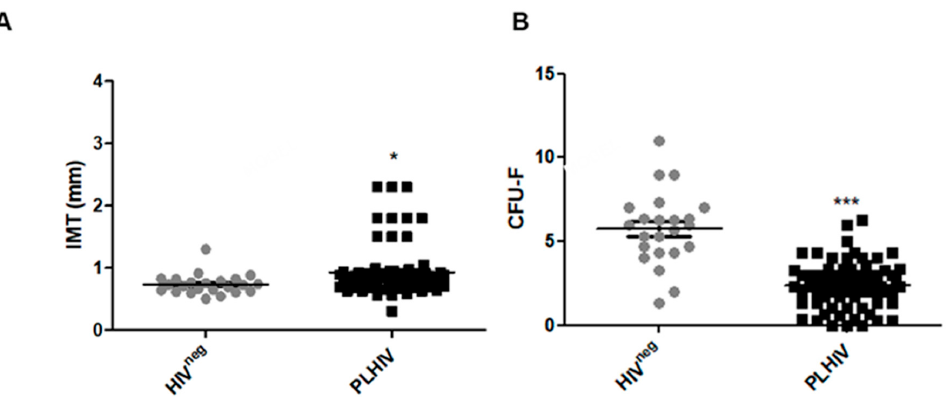
Figure 1. PLHIV have increased atherosclerosis and decreased ECFCs levels. ( A ). cIMT in PLHIV is higher than that in HIV neg subjects (* p < 0.05). ( B ). Circulating ECFC levels as determined by CFUs in PLHIV are lower than in HIV neg individuals (*** p < 0.001). PLHIV (N = 74) and HIV neg subjects (N